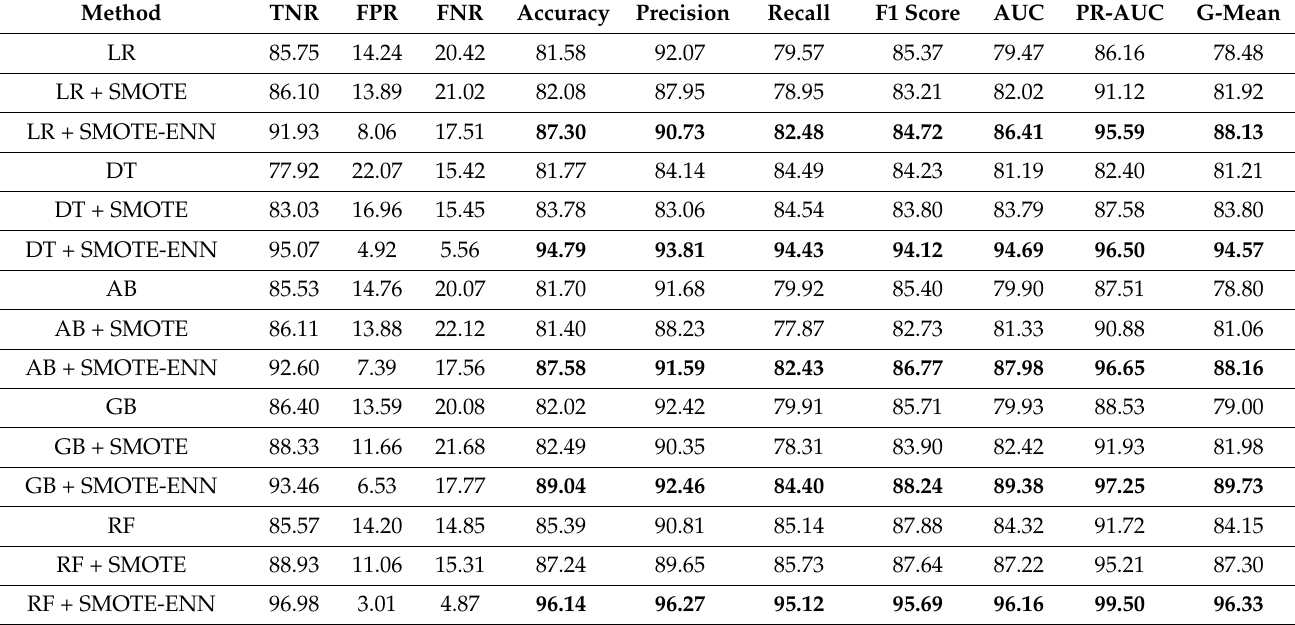
Table 4. Results of the H2